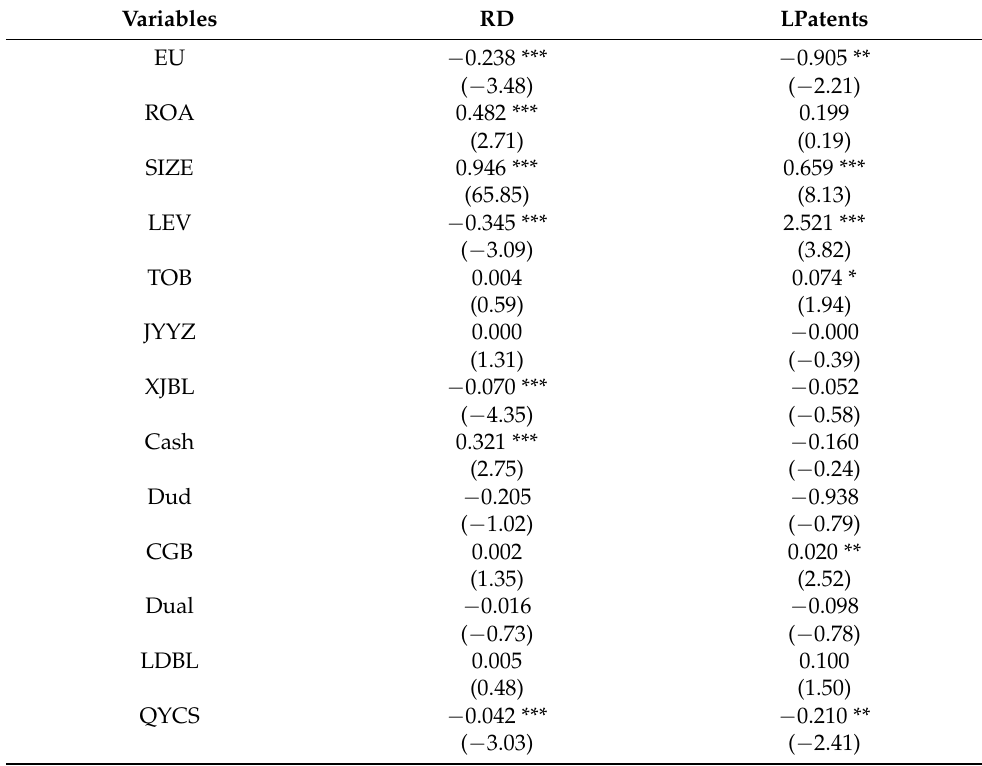
Table A3. OLS Regression (panel